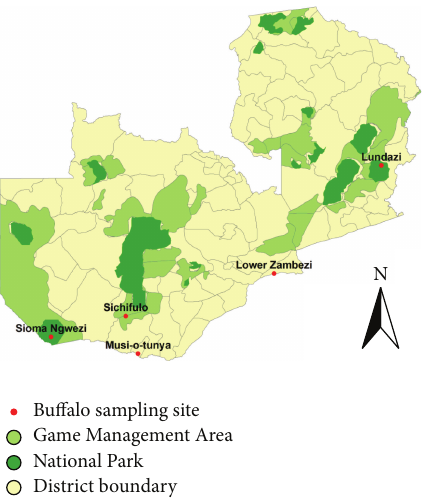
Figure 1: Map of Zambia with sampling sites in Game Management Areas (GMA) and National Parks